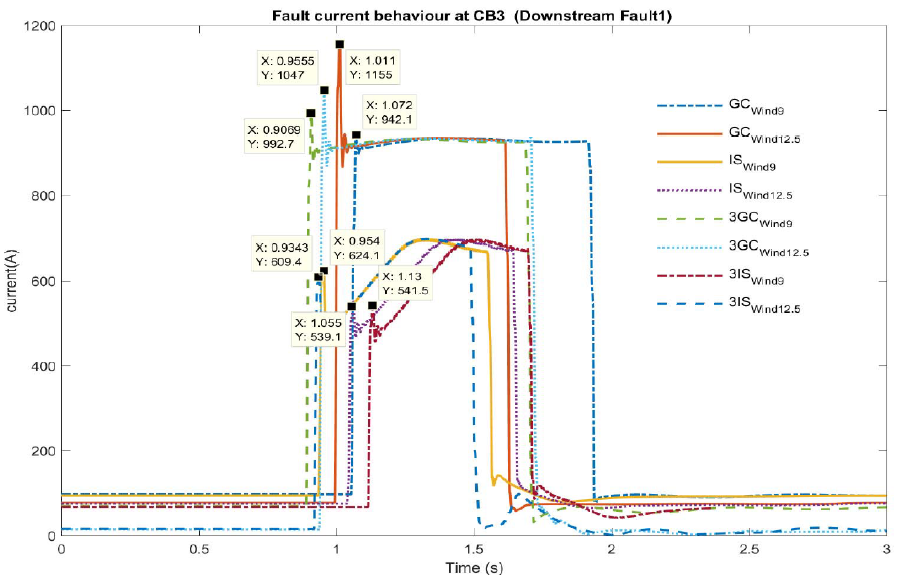
Figure 4. Variation in fault current contribution under grid-connected / islanded mode operation.